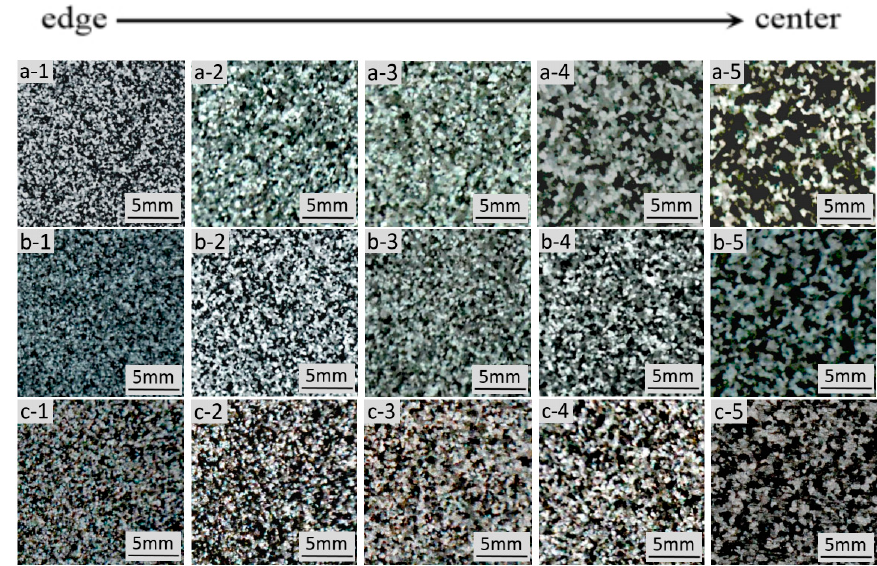
Figure 4. Macrostructure of obtained under different processing conditions: ( a ) no ultrasonic treatment; ( b ) treatment by the L-shaped ultrasonic wave guide rod; ( c ) treatment by the straight-rod ultrasonic wave guide rod.